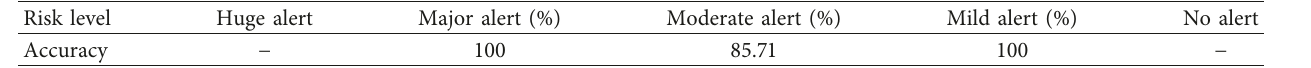
Table 10: Neusoft Group’s financial risk forecast accuracy from 2008 to 2018.